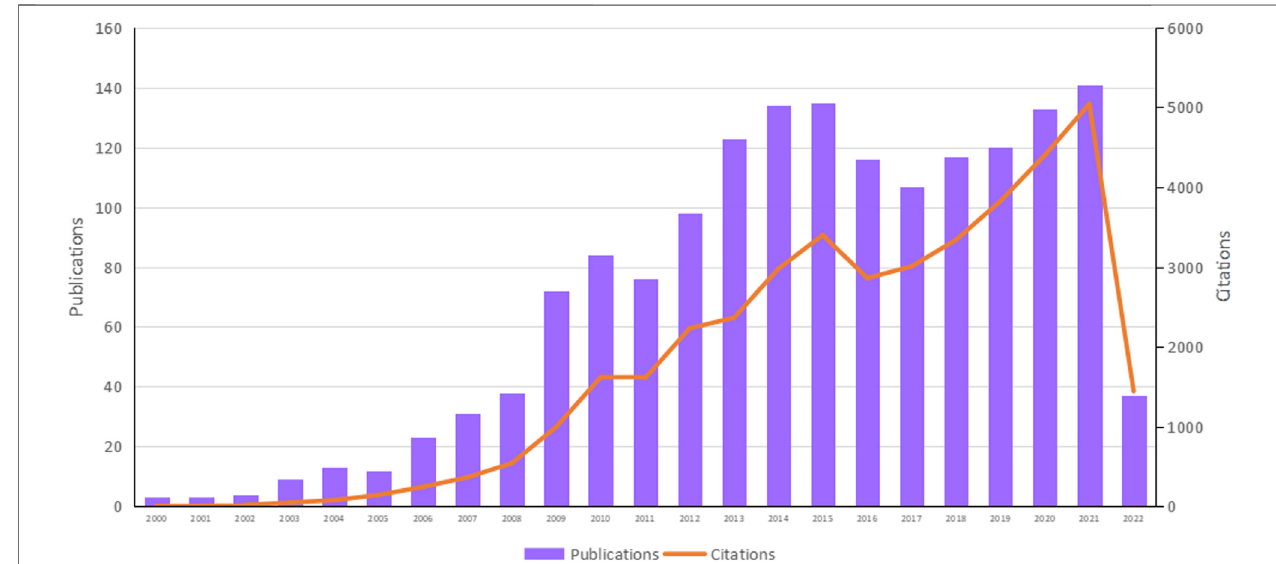
FIGURE1| Times cited andpublicationsover time inWBVTresearchsince the21stcentury.(Citations refer tothetimes cited intheyearwhen thepublication was issued).